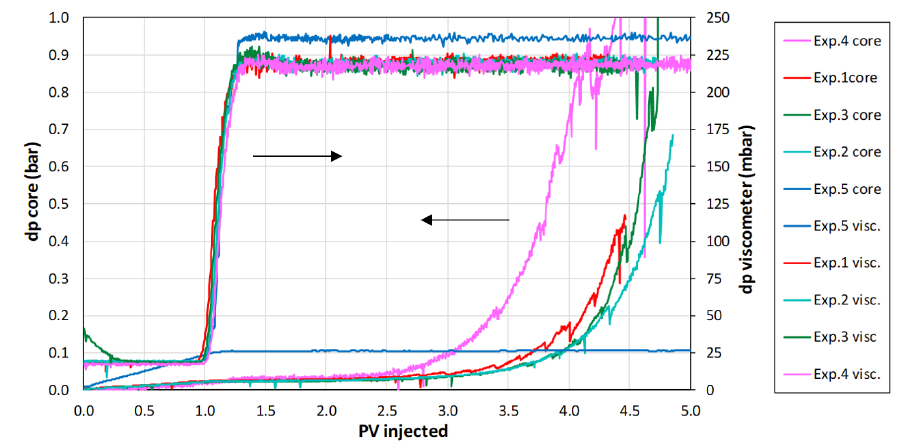
Figure 8. Comparison of nanomaterial/polymer injection